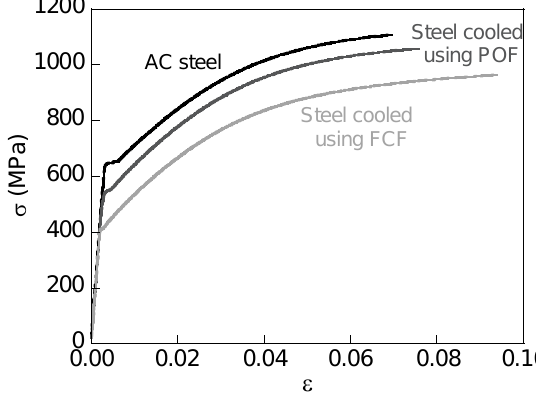
Figure 3. Stress–strain curves (standard tensile tests).